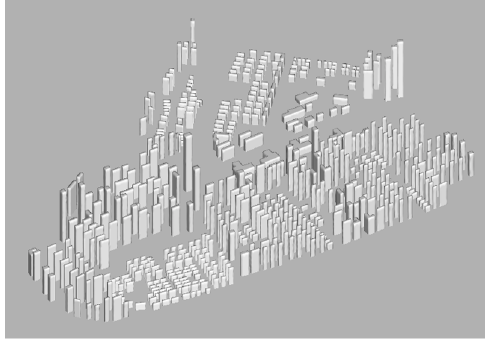
Figure 3. Physical model in computational fluid dynamics (CFD).